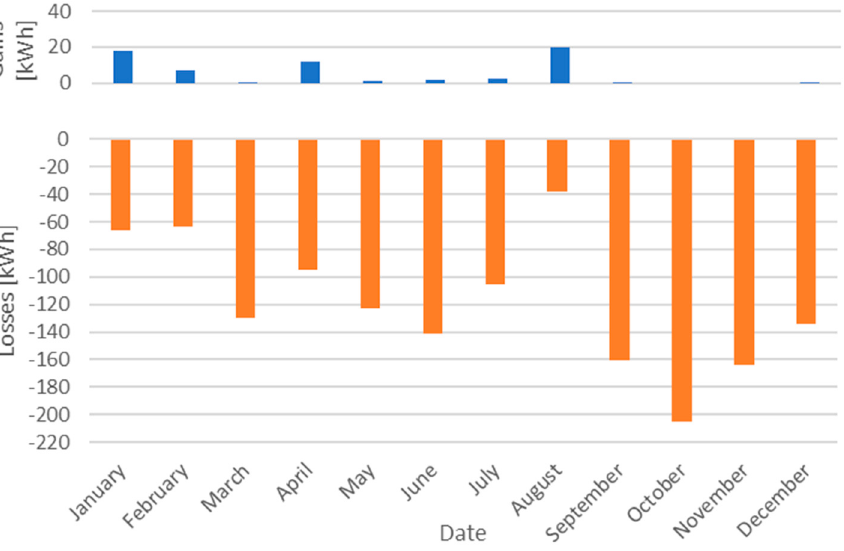
Figure 14. Monthly sum of energy flow between the floor and the ground in variant 2 (stone floor, no heating).